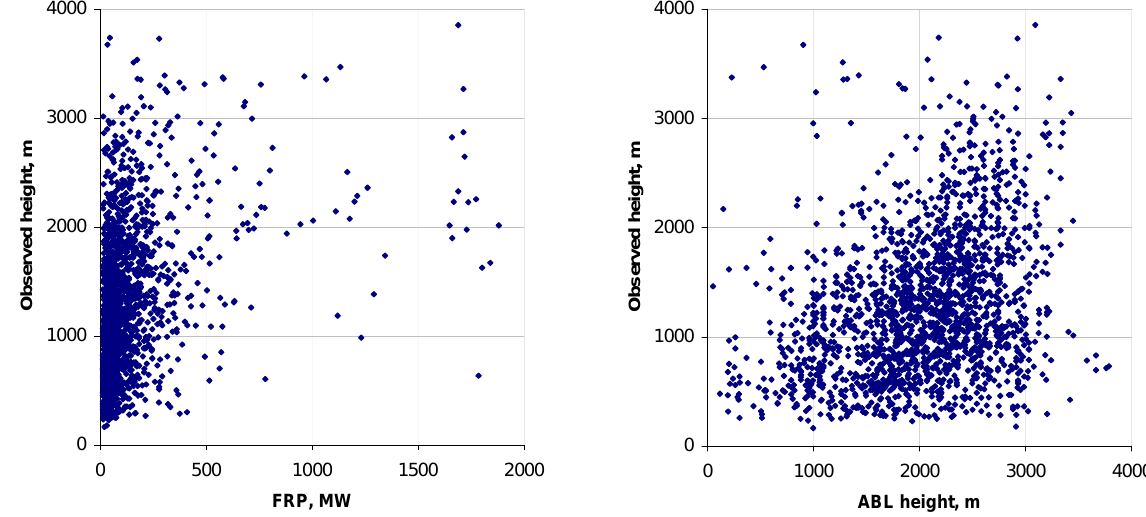
Fig. 3. Correlation of the observed plume height and individual components of the formula (10, 13): boundary layer height and